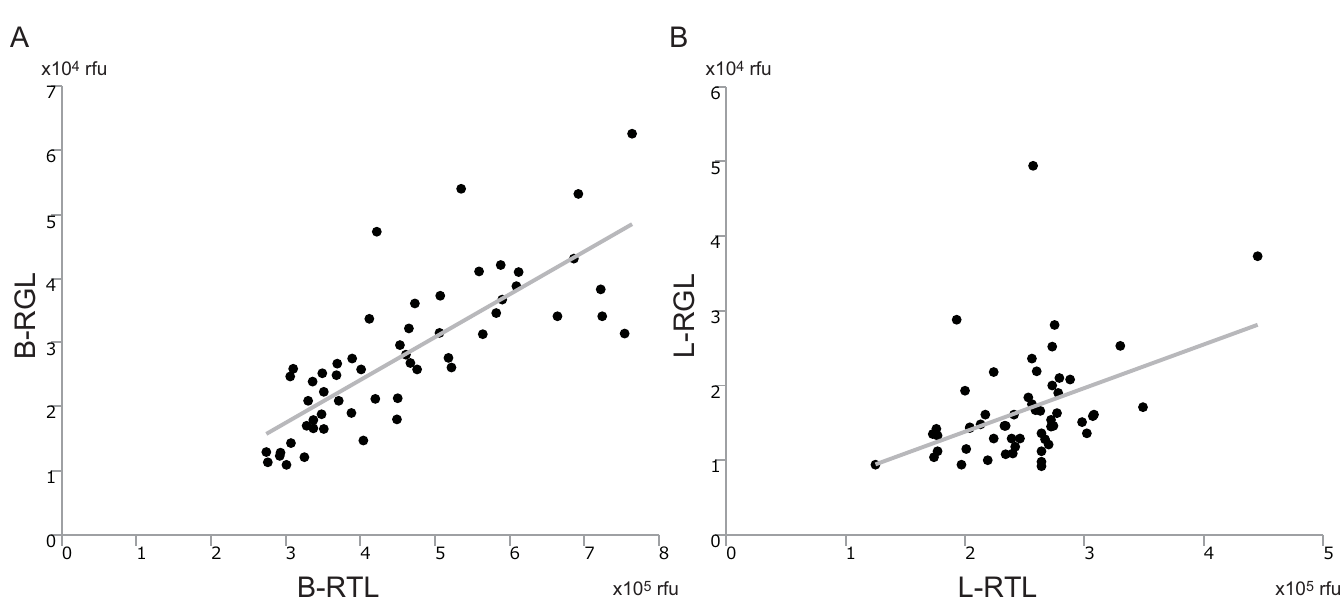
Fig 1. Correlation between telomere and G-tail length. (A) Correlation between B-RTL and B-RGL (y = 0.67 x—0.26, r 2 = 0.622, p < 0.001). (B) Correlation between L-RTL and L-RGL (y = 0.58 x + 0.21, r 2 = 0.175, p = 0.002). B-RTL; relative telomere length from blood, B-RGL; relative G-tail length from blood, L-RTL; relative telomere length from liver, L-RGL; relative G-tail length from liver.